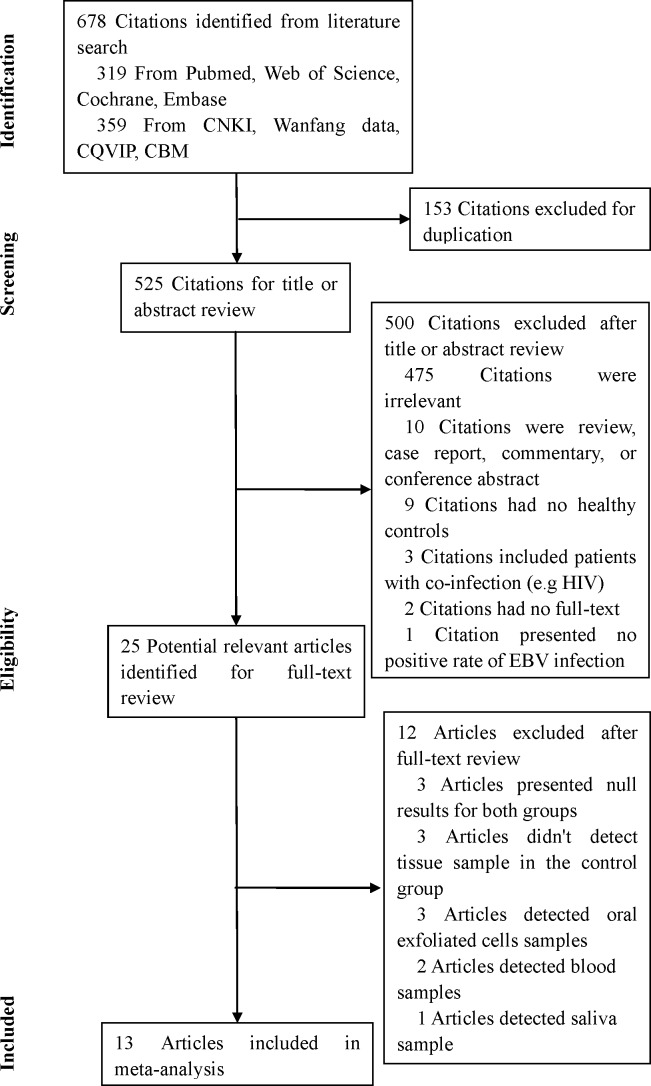
Flow diagram of the study selection process and results of the literature search.